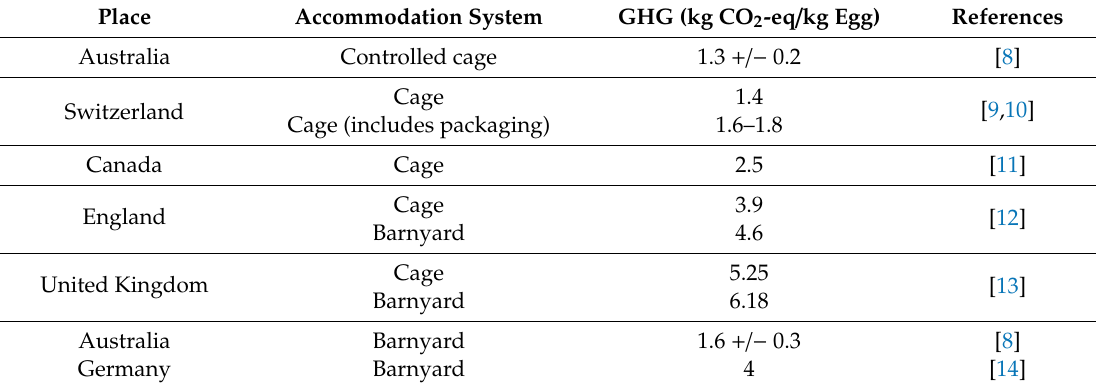
Table 1. Carbon footprint in egg production according to the poultry housing